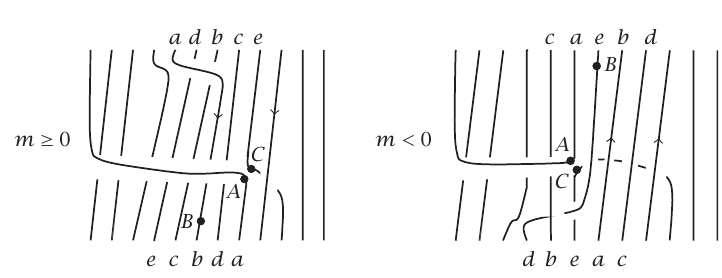
Figure 6.6 . The diagram D s obtained from D